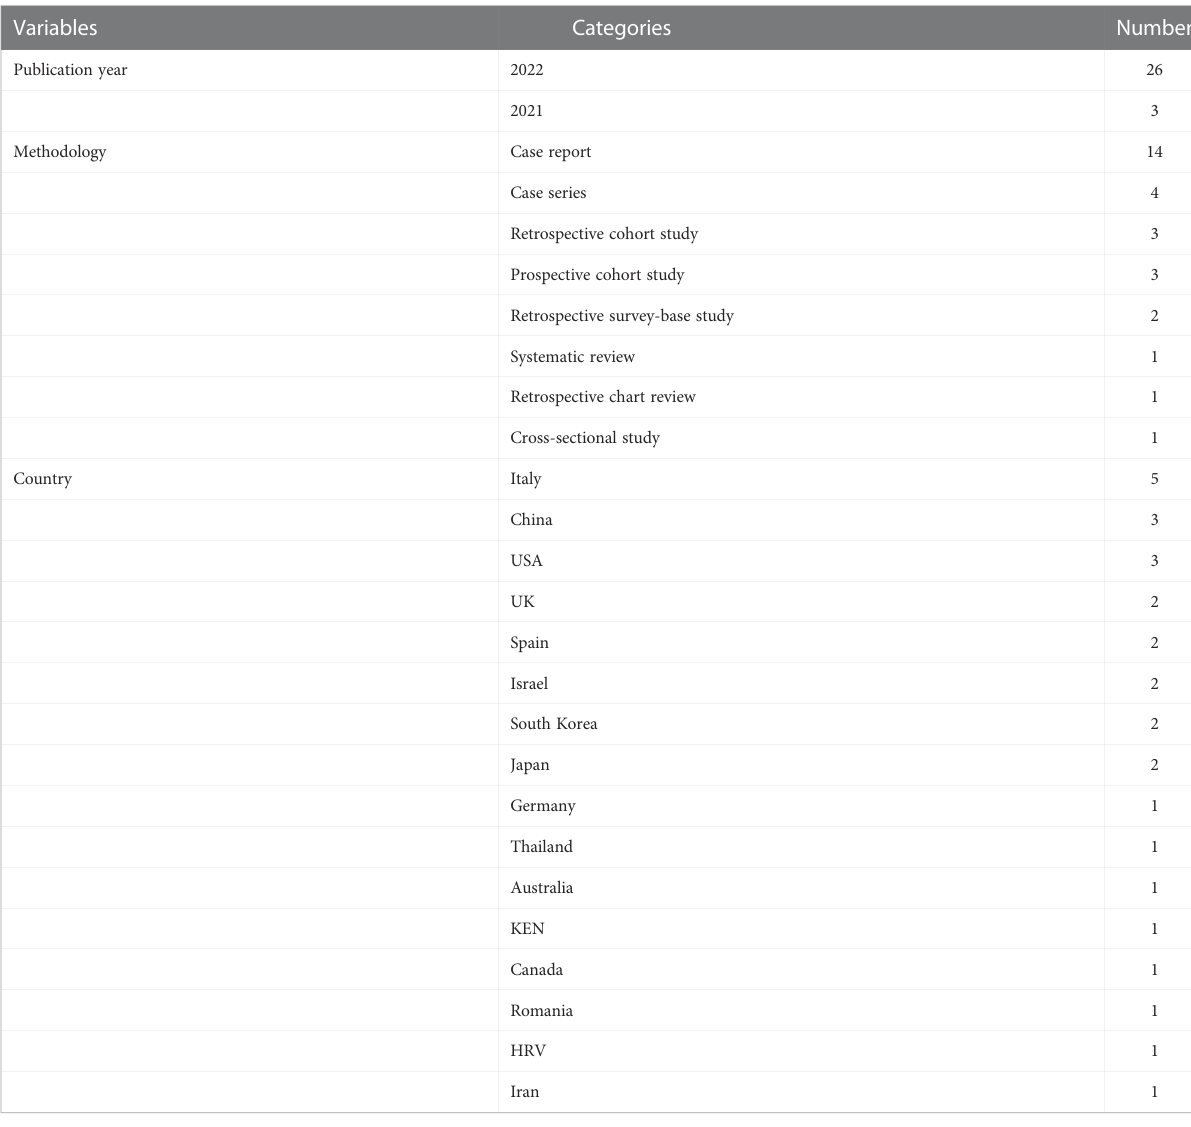
TABLE 1 General characteristics of the included